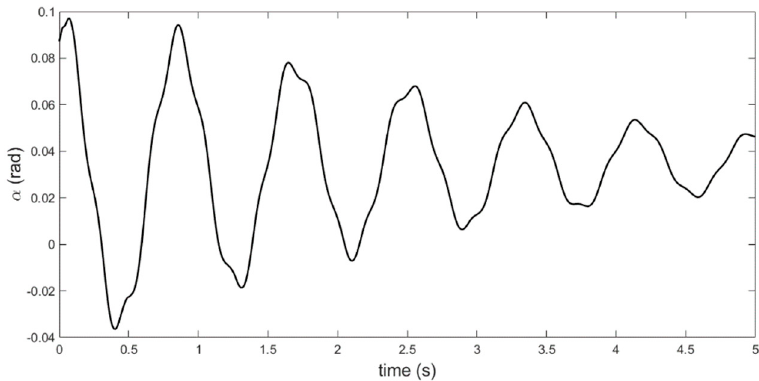
Figure 14. Time response of alpha in lower speed of flutter (20 m/s).